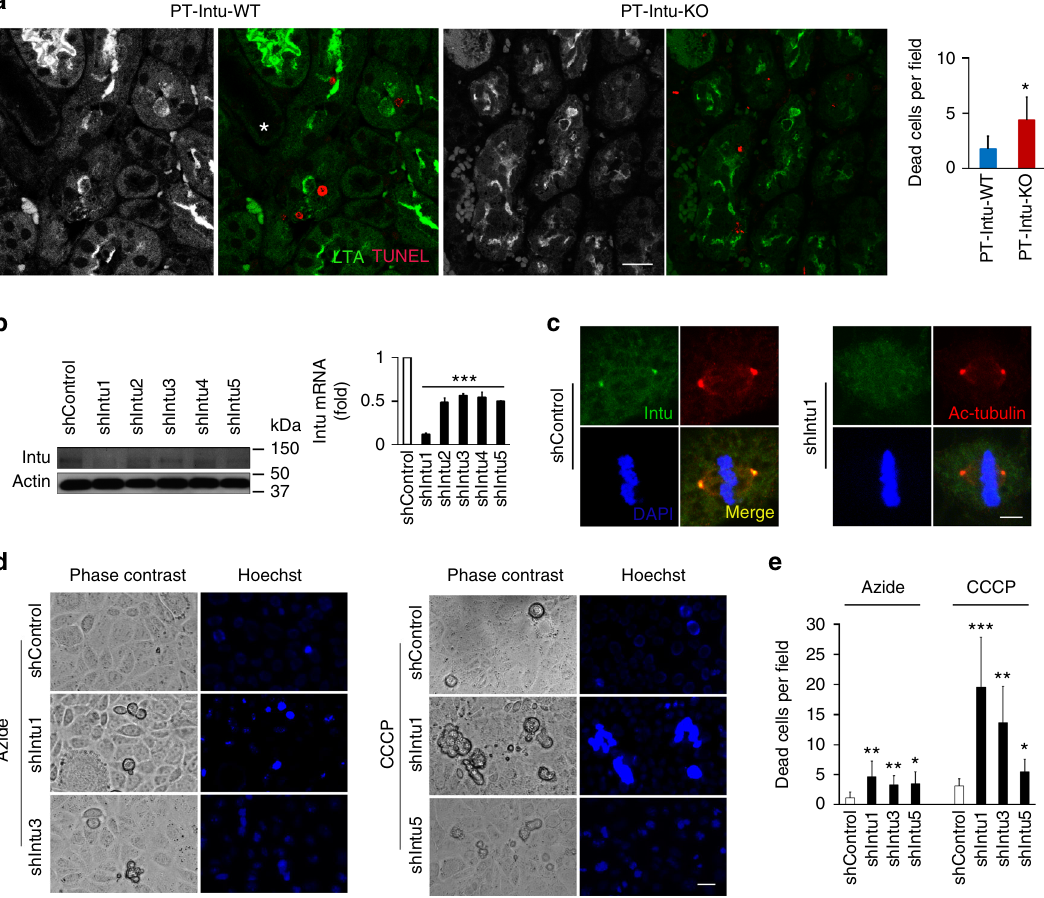
Fig. 2 Suppression of Intu increases cell death during renal IRI injury in vivo and metabolic stress in vitro. a TUNEL assay showing more death cells (red) in proximal tubules (green by LTA staining) of PT-Intu-KO kidney tissues following renal IRI than PT-Intu-WT ( n = 8). Please note that LTA staining pattern was disrupted due to injury. The asterisk indicates a likely non-PT tubule with no LTA staining and different morphology. b , c Establishment of stable Intu- knockdown BUMPT cells by transfecting Intu shRNAs (shIntu) con fi rmed by immunoblot, qRT PCR, and immunostaining. d Representative cell and nuclear images showing more cell death in Intu-knockdown cells after azide or CCCP treatment. Two knockdown clones targeting different sites were presented. e Quanti fi cation of cell death in Intu-knockdown cells and control shRNA-transfected cells after azide or CCCP treatment. Quantitative data are mean ± s.d. (error bars). Paired or grouped t test was used. * p < 0.05, ** p < 0.01, *** p < 0.001. Cell nuclei were stained with DAPI. Scale bar ( µ m): 20 ( a , d ), 10 ( c